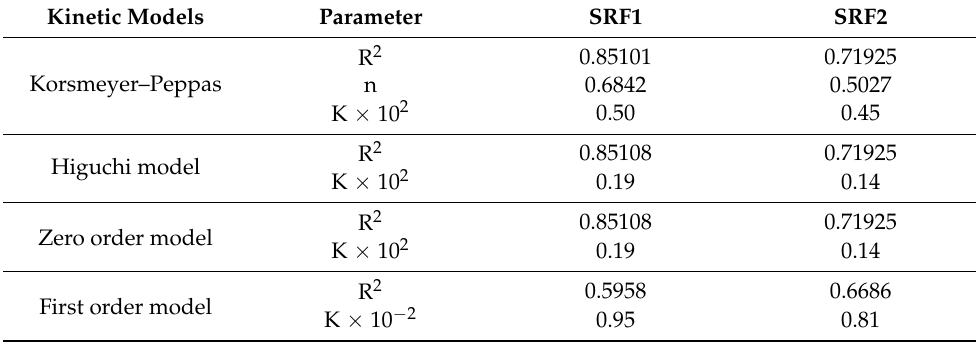
Table 2. Kinetic parameters from different model for fertilizer release in water.